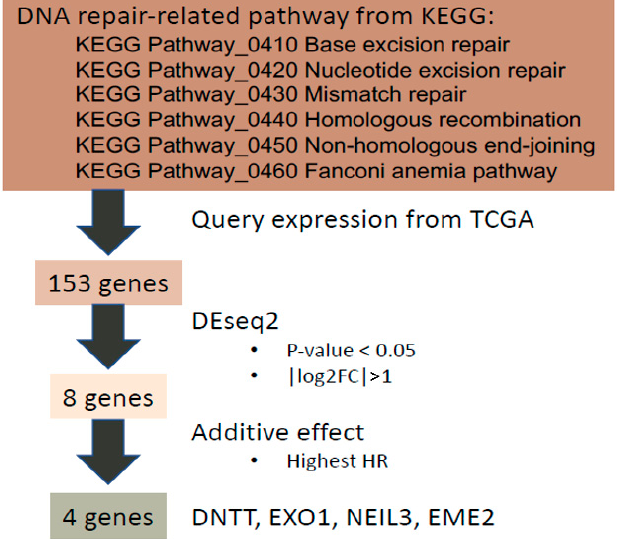
Figure 1. The workflow of developing our 4-gene panel as a transcriptomic biomarker for PC prog- nosis. Table 1. The log 2 fold change and corresponding hazard ratio (HR) of overall survival (OS) for each significantly differen- tially expressed (SDE) gene.